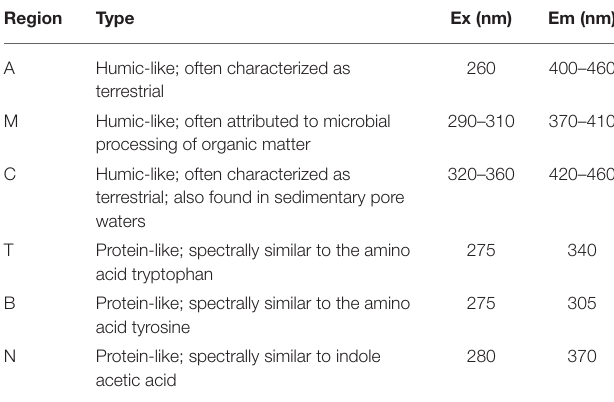
TABLE 1 | Central regions of EEM fluorescence attributed to different sources of organic matter, modified from Coble (2007) by Stedmon and Nelson (2015).